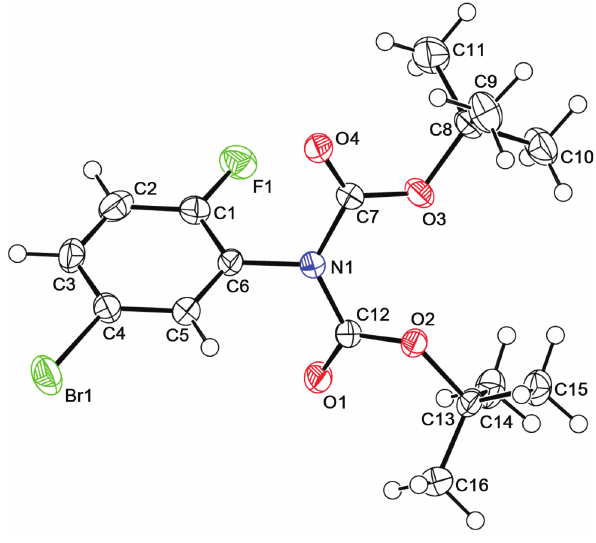
Table 1 contains crystallographic data and Table 2 contains the list of the atoms including atomic coordinates and dis- placement parameters.